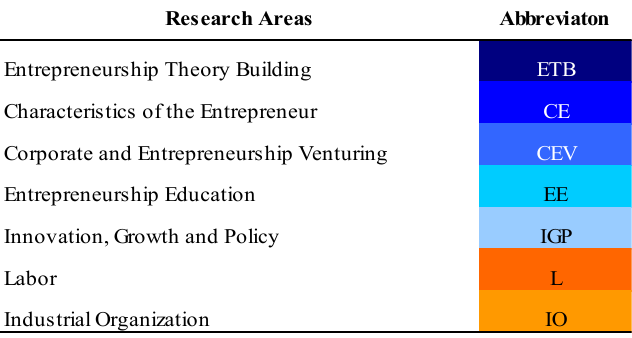
Table 4: Areas of scientific research associated with top cited